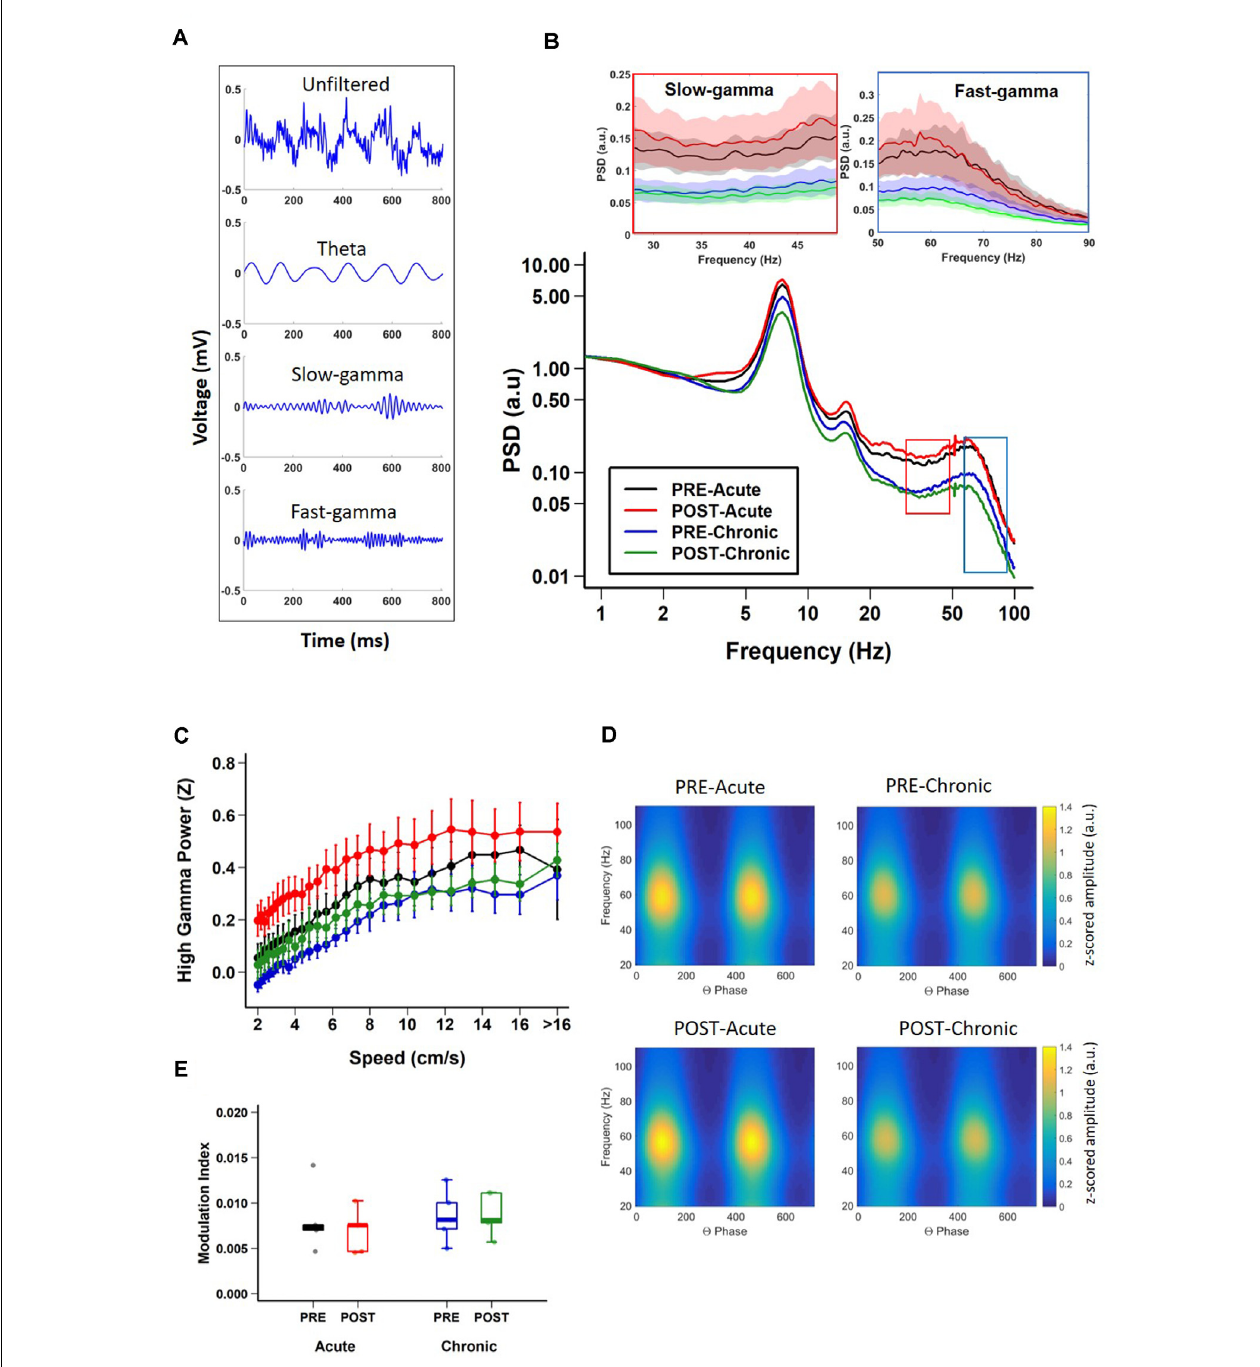
FIGURE 2 | Impact of stress on CA1 oscillatory activity. (A) Representative examples of unfiltered (top) and filtered (bottom) local field potentials (LFPs) during track exploration for theta, slow-gamma, and fast-gamma. (B) Power spectral density (PSD) curves of CA1 LFPs during linear track exploration (RUN) show no significant differences for theta (6–12 Hz; Theta, 2-way repeated measure ANOVA: day, main effect of day F (1,19) = 2.7018, p = 0.1262; main effect of session, F (1,19) = 0.0427, p = 0.8398; interaction, F (1,19) = 0.4823, p = 0.501). Fast-gamma (55–90 Hz) showed an effect of day but not of session (FG, right inset ; 2-way repeated measure ANOVA: main effect of day, F (1,19) = 6.7062, p = 0.0237; main effect of session, F (1,19) = 0.1047, p = 0.752 interaction, F (1,19) = 0.2074, p = 0.657). Slow-gamma (30–50 Hz) showed an effect of day but not of session (SG, left inset , 2-way repeated measure ANOVA: main effect of day, F (1,19) = 8.3668, p = 0.0135; main effect of session, F (1,19) = 0.0634, p = 0.805; interaction, F (1,19) = 0.3754, p = 0.551). (C) Relationship between FG power and running speed on the track (FG; 2-way repeated measure ANOVA : main effect of speed, F (1,36) = 471.385, p < 2.22 × 10 − 16 , main effect of group, F (3,36) =